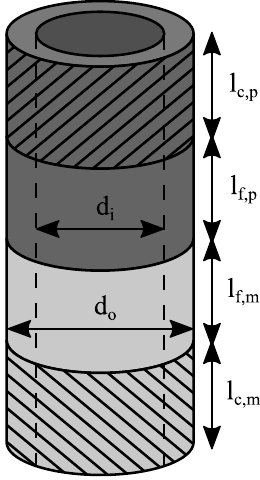
Figure 2. Hollow cylinder specimen geometry.